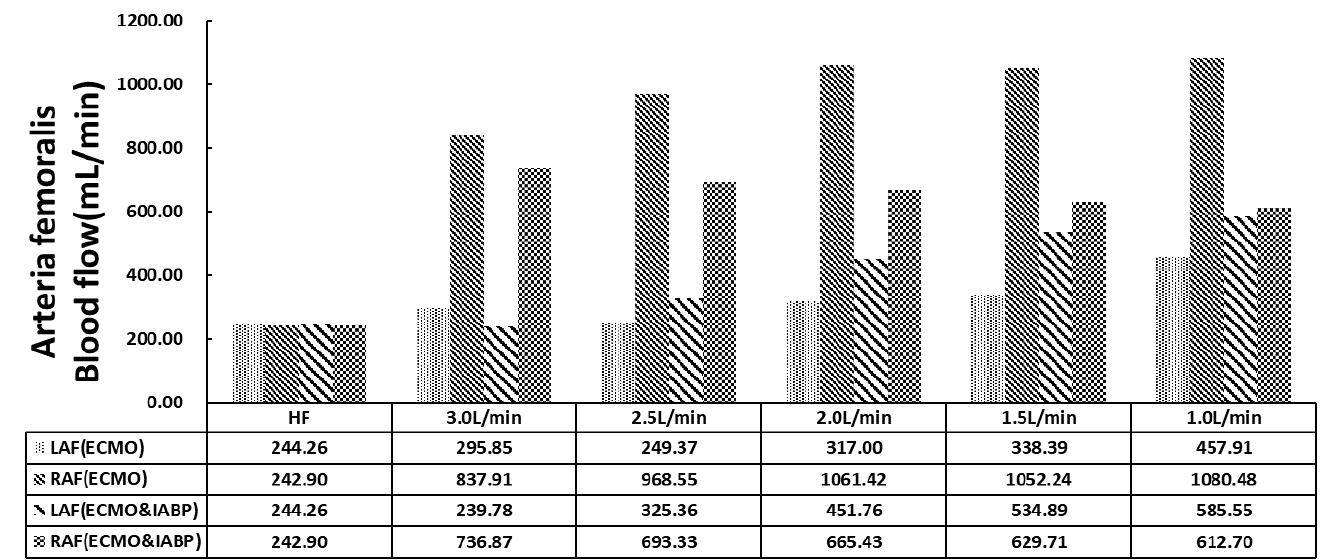
Figure 4. The histogram of arteria femoralis flow.